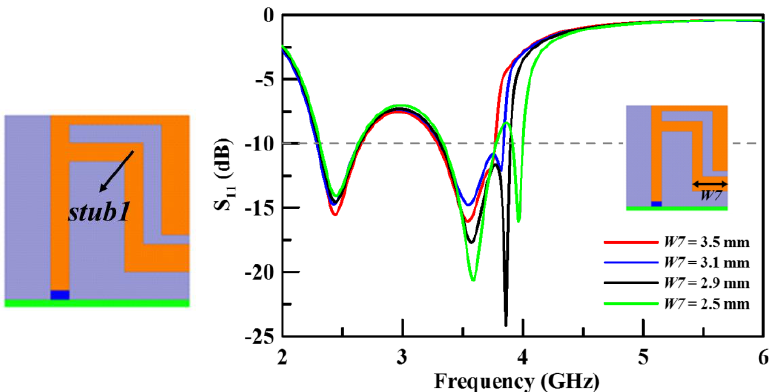
Figure 5. The simulated return loss with various lengths of W7 (Step 2).